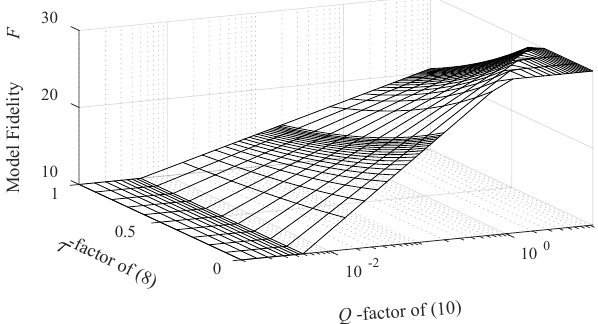
Figure 3. The dependence between the model fidelity and the convergence status Q , as well as aggregated constraint violation τ , cf. (13) and (14). Except from the initial stages of the optimization process and when approaching convergence, this dependence is a monotonic function of both control factors. The surface plot is created for exemplary model resolution levels F min = 10, F max = 30, assuming δ th = 5 × 10 − 3 .